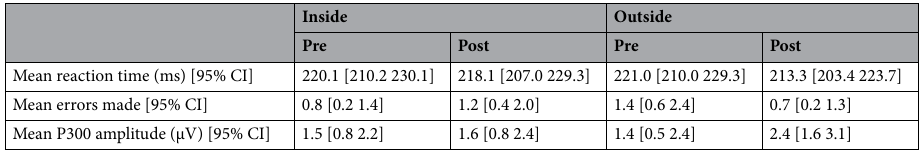
Table 1. Summary statistical results. 95% CI 95% confidence intervals.